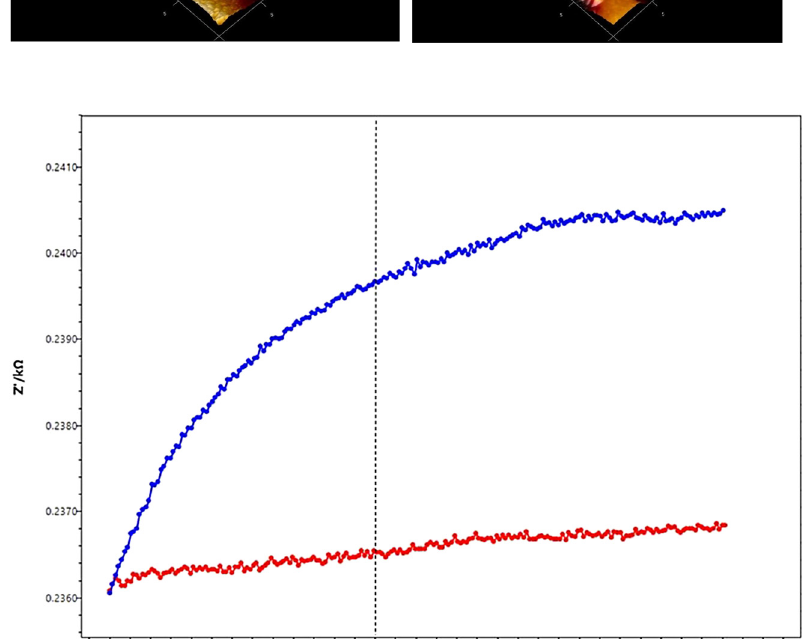
Figure 2: SEM and AFM images of LNCaP biosensor indicate successful modification steps. A. SEM images of GNPE, B. SEM images of GNPE-Apt-LNCaP modification, C. AFM images of GNPE, D. AFM images of GNPE-Apt-LNCaP modification.